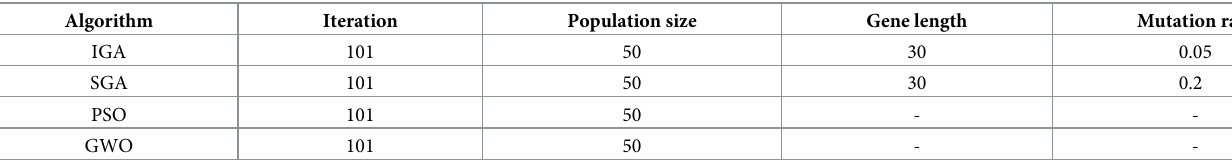
Table 4. The parameter settings.